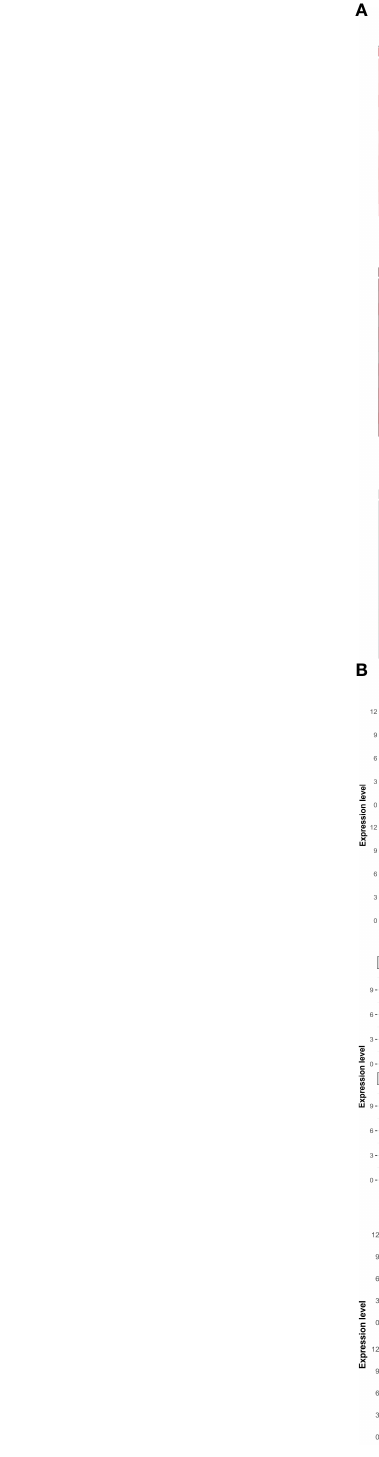
FIGURE 2 Identi fi cation of COVID-19 subtypes based on expression pro fi les of the 13 upregulated genes in COVID-19 patients. (A) Hierarchical clustering identifying two COVID-19 subtypes: COV-C1 and COV-C2, consistently in three datasets. (B) The 13 genes have signi fi cantly higher expression levels in COV-C2 than in COV-C1. Two-tailed student ’ s t test P -values are shown. **** P <